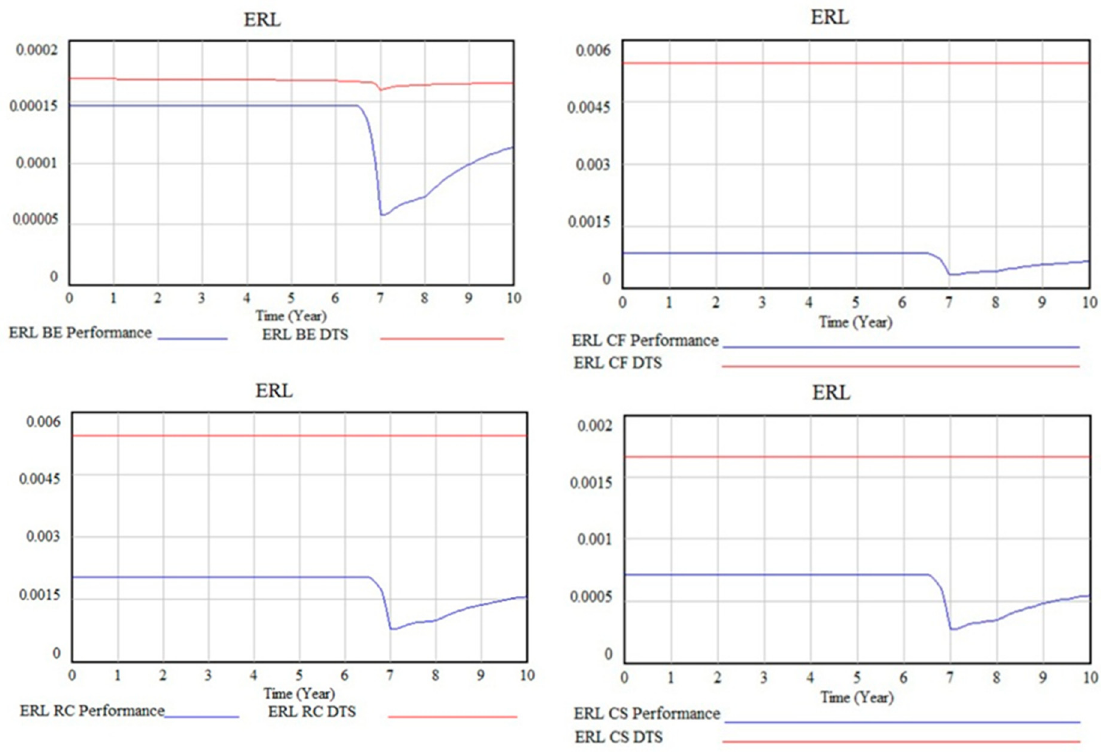
Figure 19. SD result- DTS vs. Performance solution. Risk profile over 10-year period (Case #1). During the 10-year life span considered, the performance solution shows a lower level of risk than the DTS solution. It can also be noted that there is no variation in risk for the DTS solution over 10 years; this is because the DTS solution has no active fire protection measures (detection or suppression system), hence no HOEs can significantly alter the level of risk. However, outside the active protection system, it is always possible